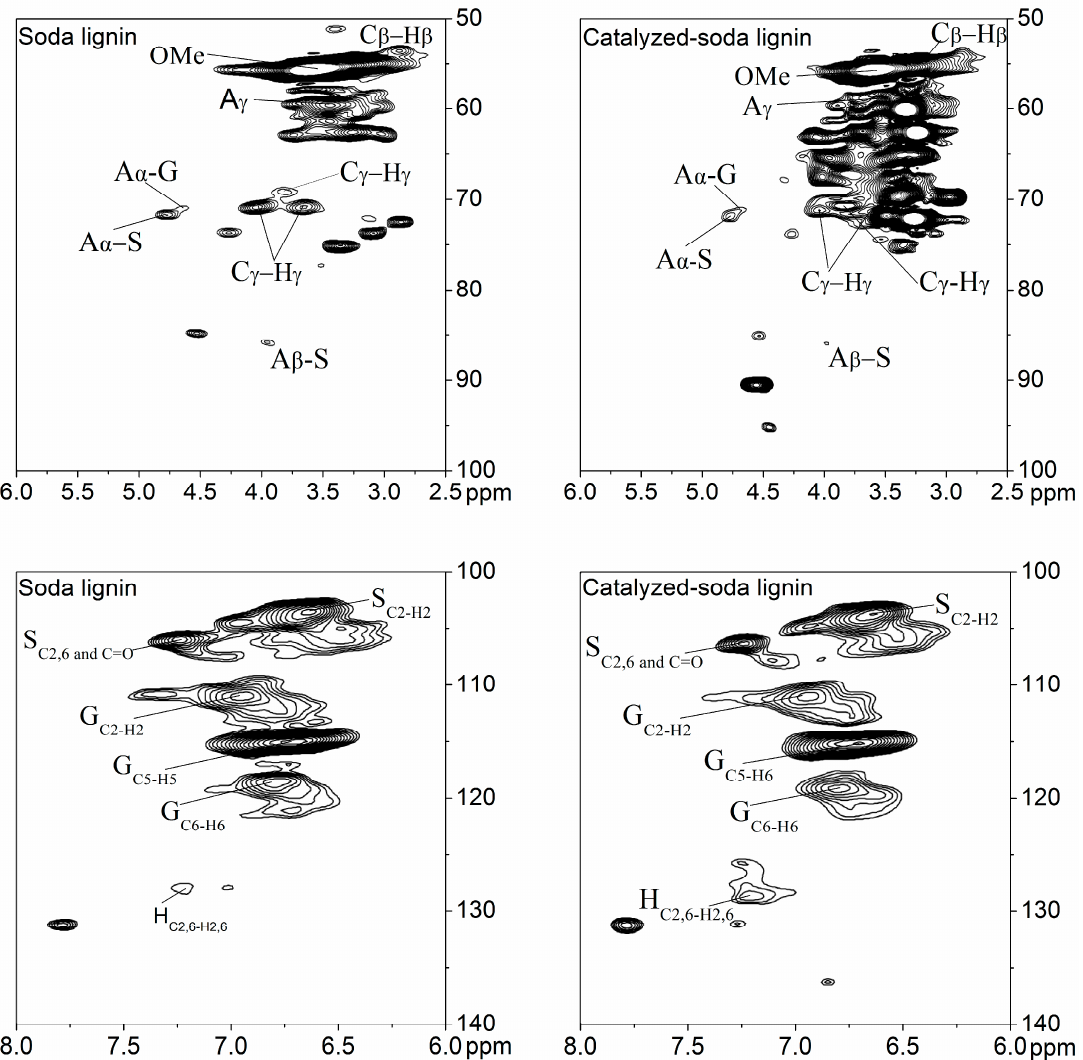
Figure 5. 2D-HSQC NMR spectra of the soda lignin and catalyzed-soda lignin.